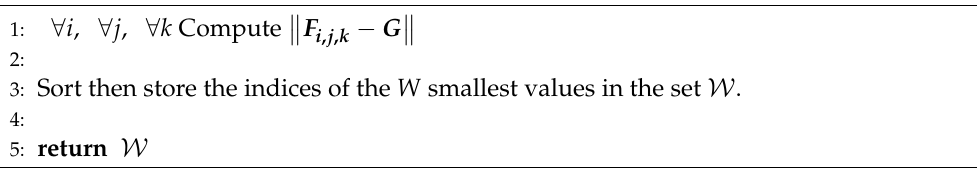
Algorithm 1 Generate Closest Fingerprints.